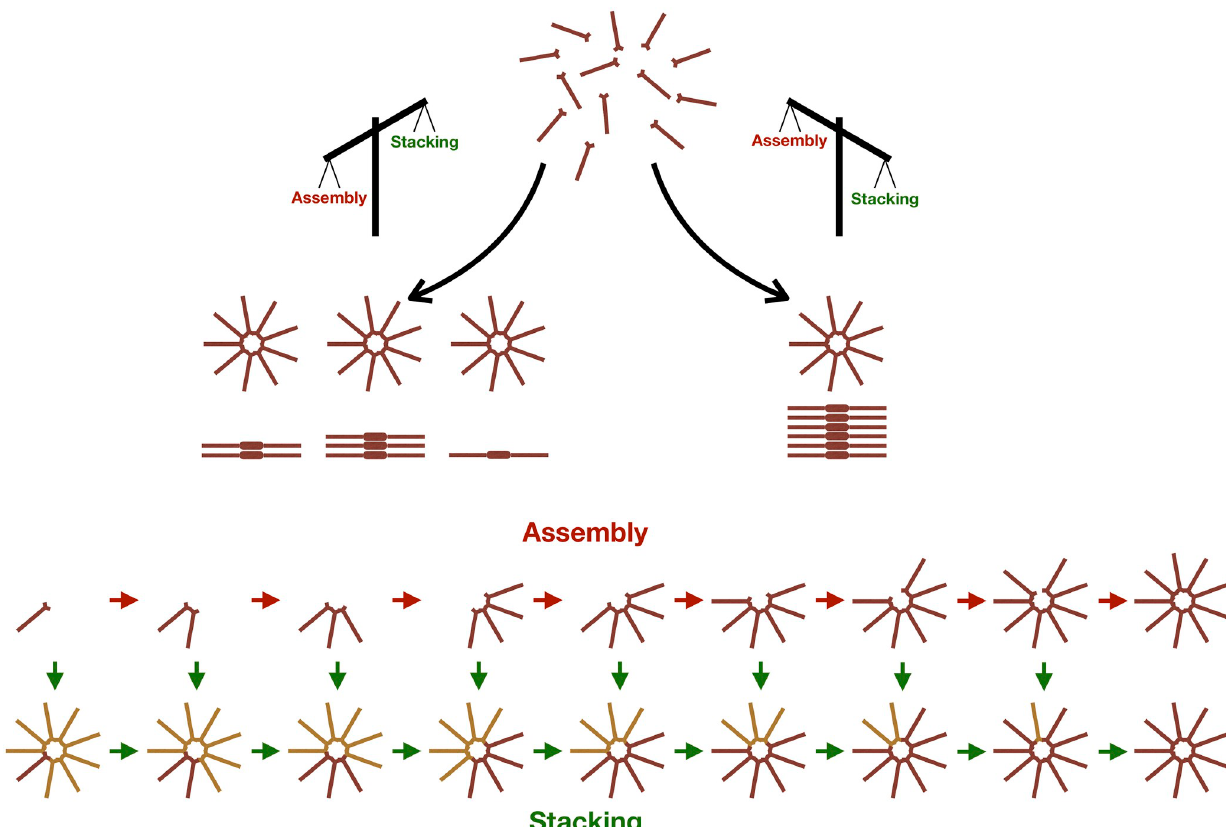
Fig 1. General scheme of the model. The SAS-6 dimer is the basic subunit of the carwheel. Higher-order oligomers can arise through oligomerisation of SAS-6 dimers. Once oligomers grow to assemble a complete ring, it is assumed that an independent cartwheel is formed. After the first cartwheel is formed it can elongate by stacking intermediate oligomers onto the top ring layer. Thus, stacking can deplete the pool of available dimers and oligomers necessary to assemble supernumerary cartwheels.